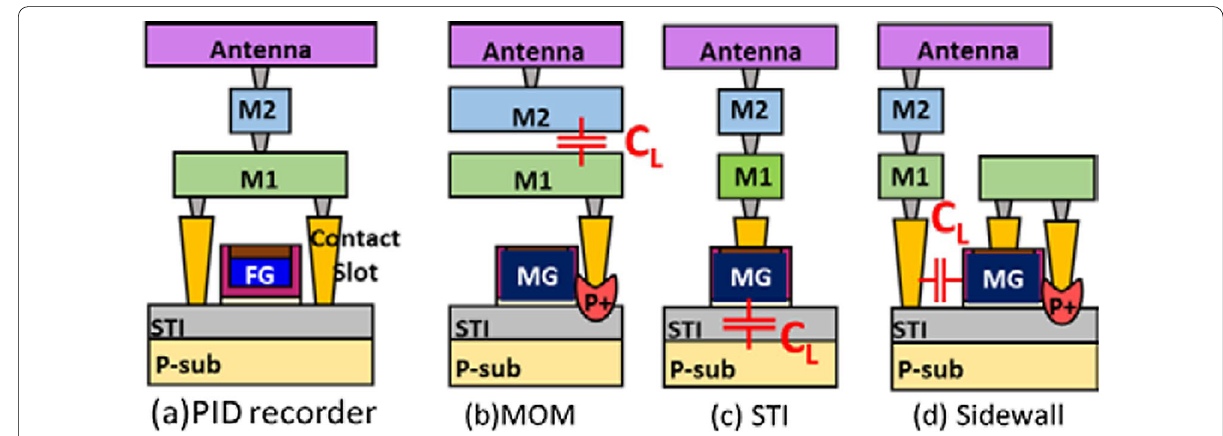
Fig. 6 Cross sectional illustration of a the in‑situ PID detector, and those with a loading additional capacitor realized by b MOM, c STI, and d sidewall, respectively